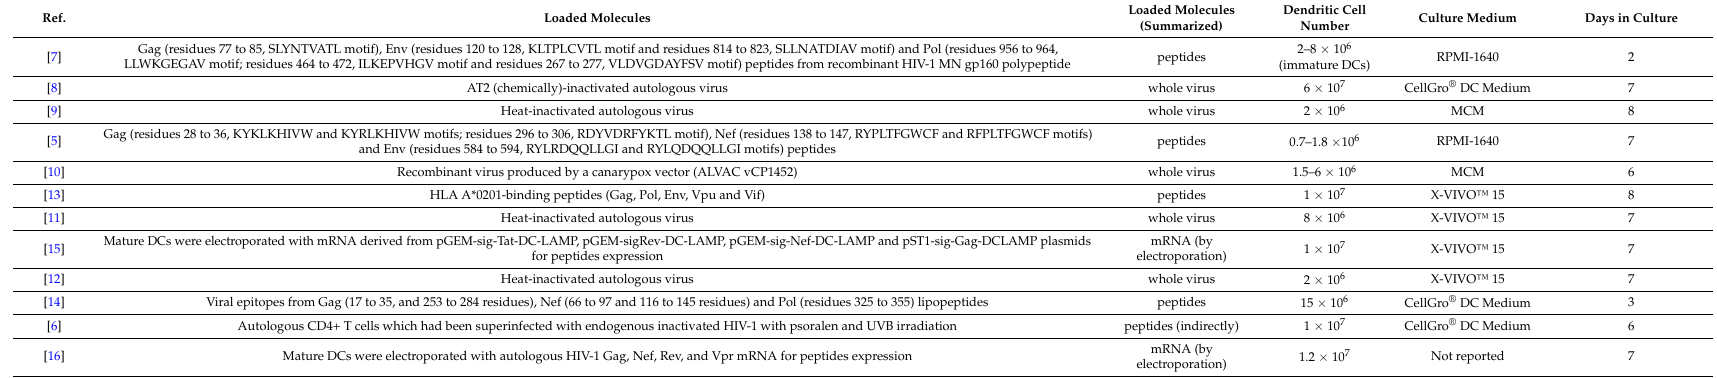
Table 3. Summary of technical differences among the protocols of the 12 studies that were included in the meta-analysis. Ref.